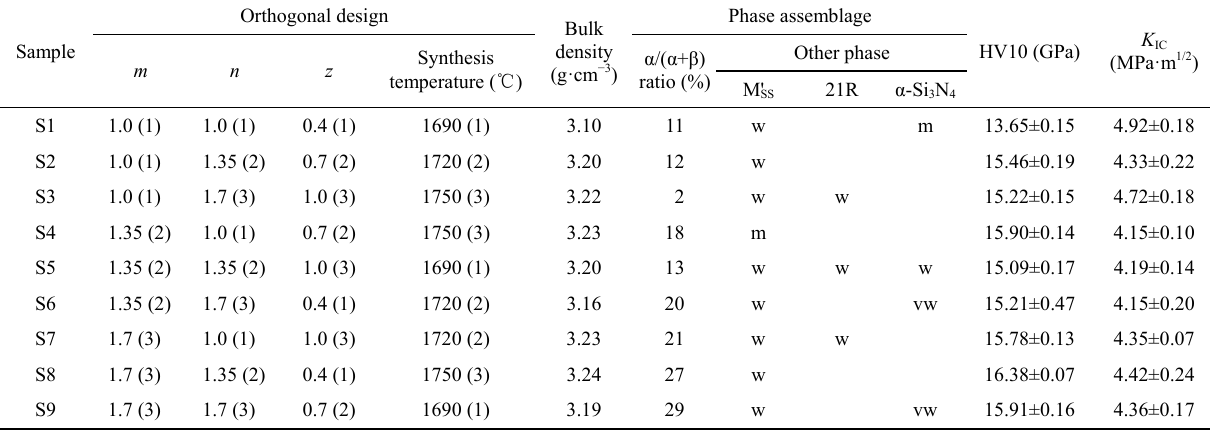
Table 1 Orthogonal design and corresponding bulk density, phase assemblage, and mechanical properties of the α / β -SiAlON ceramics a Orthogonal design Phase